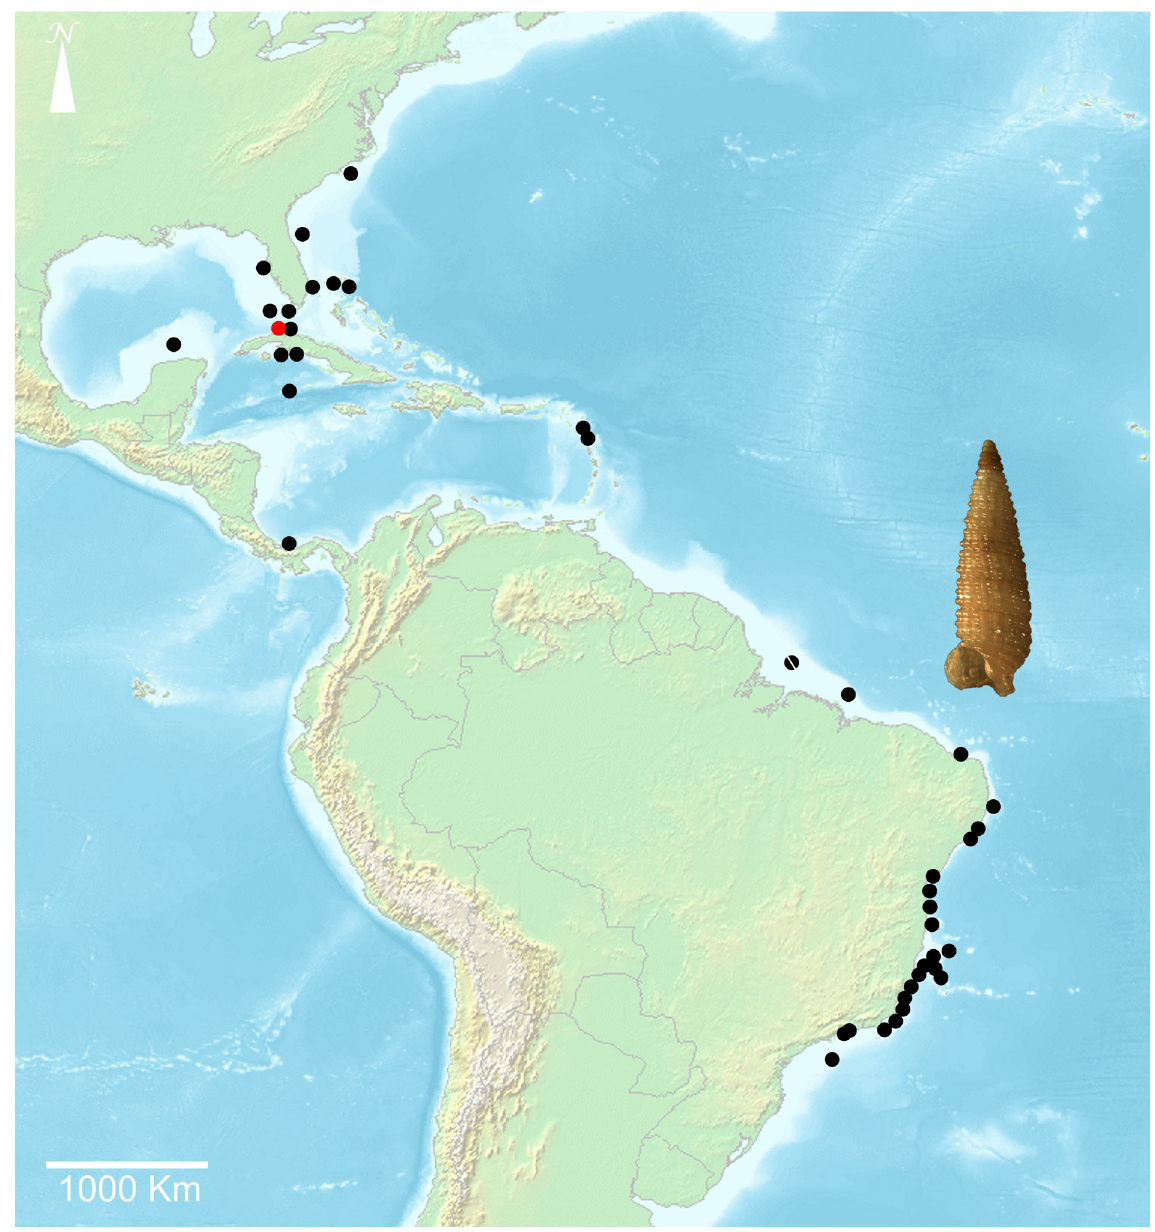
Fig. 62. Distribution map of Sagenotriphora osclausum (Rolán & Fernández-Garcés, 1995); red circle = type